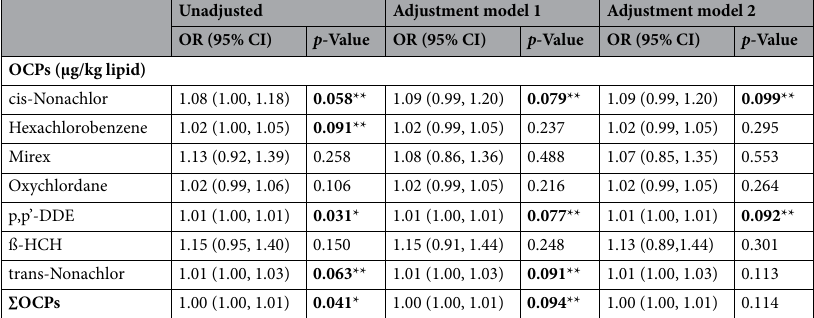
Unadjusted Adjustment model